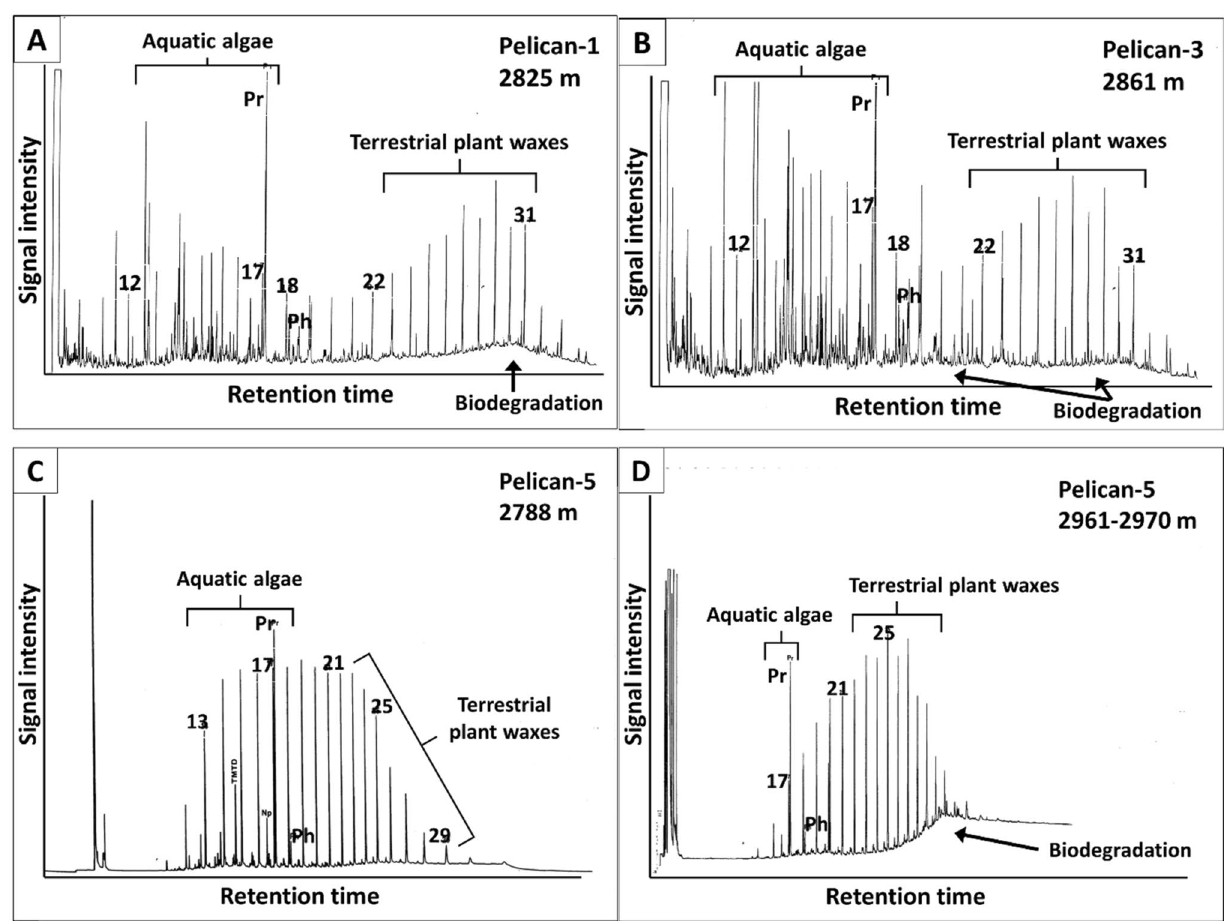
Fig. 13 Gas chromatograms of extracted saturates of samples from the Narimba Formation Fig. 14 Cross-plot of Pr/nC 17 versus Ph/nC 18 showing deposi- tional environment and maturity level (modified from Peters et al.